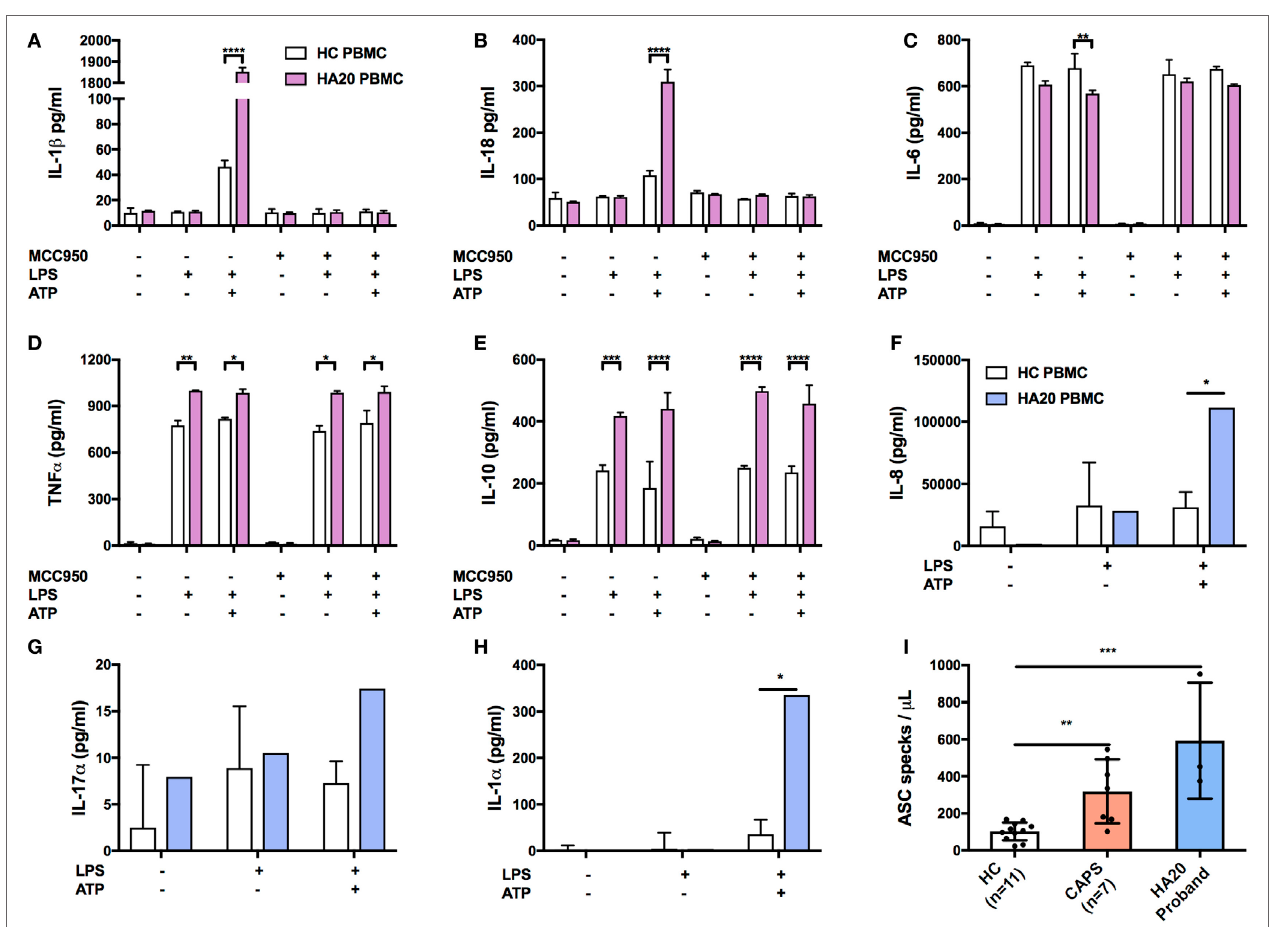
FIGURe 3 | Pro-inflammatory response in A20-deficient patient. Cytokines were measured by ELISA using supernatant from patient and healthy donors. The median confidence interval presented from two separate patient samples. PBMCs were treated with or without MCC950 (NLRP3 inhibitor) and stimulated for 4 h with LPS (10 ng/mL) followed by 1 h ATP (1 mM). Pro-inflammatory responses to NLRP3-dependent activation of (a) IL-1 β and (B) IL-18, and in measurements of (C) IL-6, (D) TNF α , (e) IL-10, (F) IL-8 xtbf, (G) IL-17 α , and (H) IL-1 α . The median confidence interval or repeated patient measurements is presented. A two-way ANOVA statistical test was performed (*p < 0.05, **p < 0.01, ***p < 0.001, and ****p < 0.0001). (I) ASC specks found in the HA20 patient at twice the normal range indicate NLRP3 inflammasome activation and pyroptosis. Treatment concentrations as described in panel (a) . Measurements were taken for 7 CAPS patients which also represent a pro-inflammatory response although not as profound as the HA20 response. ASC specs were measured as previously described